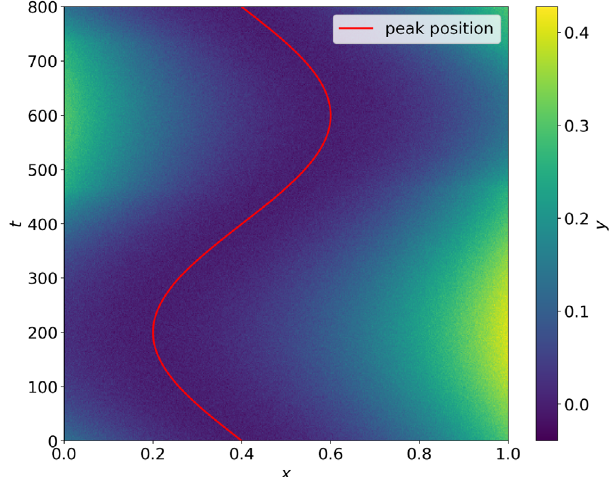
FIG. 4. Test function surface evolution with time. The drifting period p is set to 800, and the drifting amplitude σ is 0.2. The d noise level σ is 0.01. The red curve is the peak position of the test n function that changes with